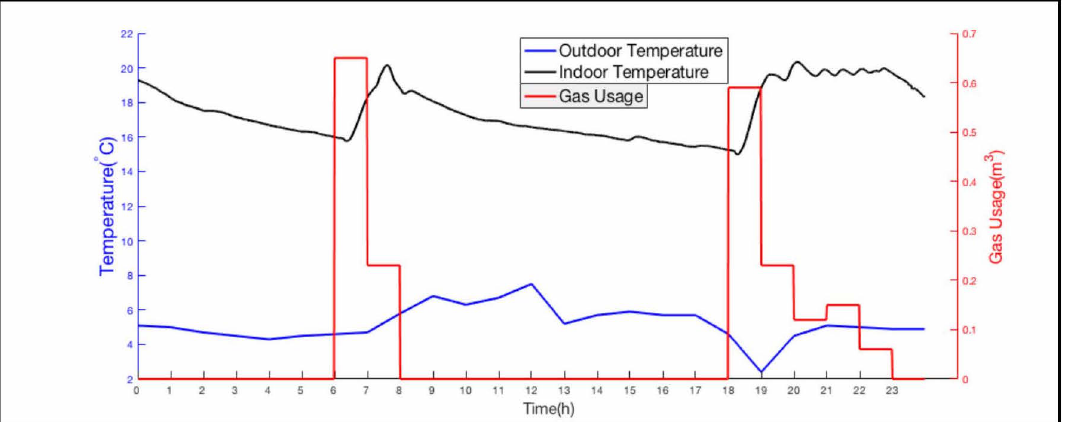
Figure 4. Gathered data from one sample house for 24